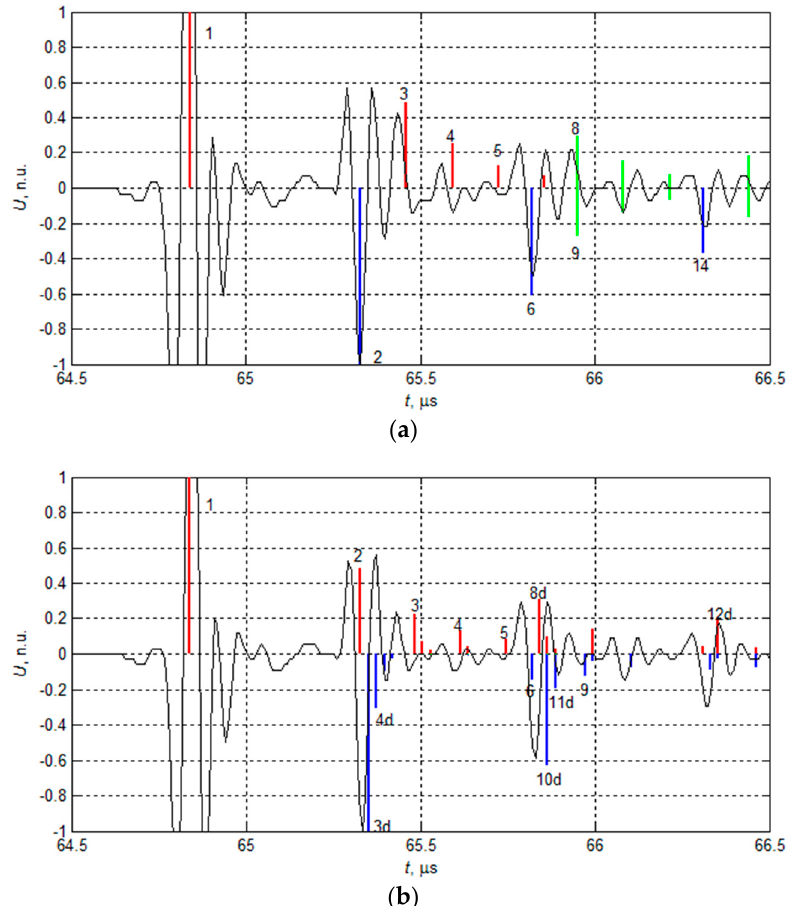
Figure 8. Measured signal and impulse response function overlay: sample part without defect ( a ) and defected ( b ). The black line denotes the measured ultrasonic signal, and the color bars denote the reflected impulse time moments presented in Figure 7.